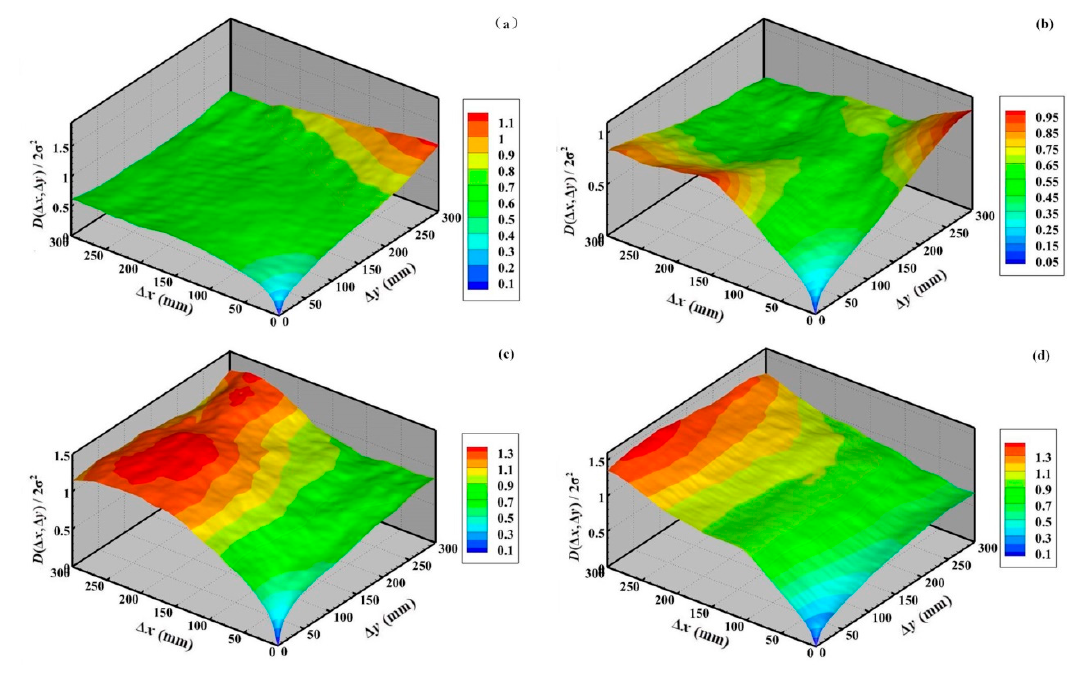
Figure 7. The second-order structure function plot of Run 1 and Run 2: ( a ) Run 1-0; ( b ) Run 1-1; ( c ) Run 2-0; and ( d ) Run 2-1.